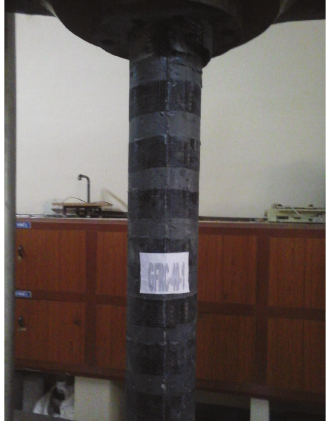
Figure 4: Failure pattern of NC-20-1.